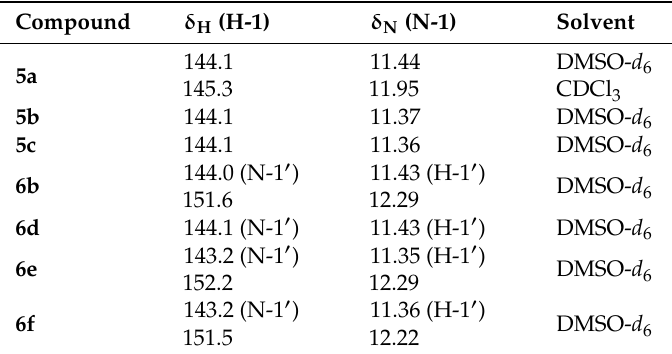
Figure 3. Structure of 4-(prop-2-yn-1-yloxy)quinolin-2(1 H )-one: 5a rather than 8 . Table 1. 1 H- 15 N HSQC correlations in Series 5 and 6.